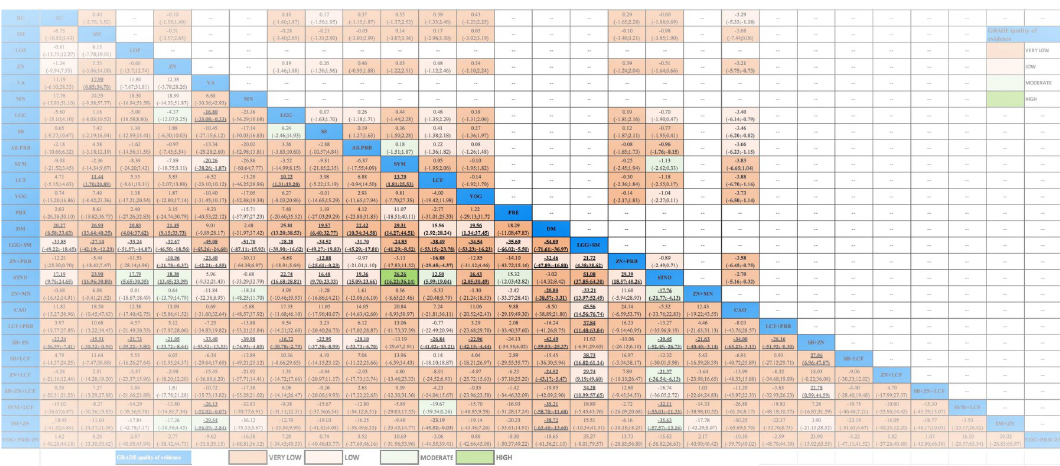
Fig 3. League table with NMA estimates for diarrhea duration and stool frequency at day 2. Comparisons should be read from left to right. The effectiveness estimate is located at the intersection of the column- defining treatment and the row-defining treatment. Diarrhea duration (bottom part of the table) effect estimate is presented in mean difference in hours with the 95% CrI, an MD below 0 favors the column- defining treatment (fewer hours of diarrhea). Stool frequency at day 2 (upper part of the table) effects estimate is presented in mean difference in the number of stools with the 95% CrI, an MD below 0 favours the column-defining treatment (fewer stools per day). To obtain MDs for comparisons in the opposing direction, negative values should be converted into positive values and vice versa. Significant results are in bold and underlined. Cells filling represent the GRADE quality of evidence assessment: Green: High quality; Light Green: Moderate quality; Light Orange: Low; Darker Orange: Very Low. Blank cells: not available interventions and comparisons MD: Mean difference; 95CrI%: 95% Credible Intervals; NMA: Network Meta- analysis. Interventions’ abbreviations are described in Table